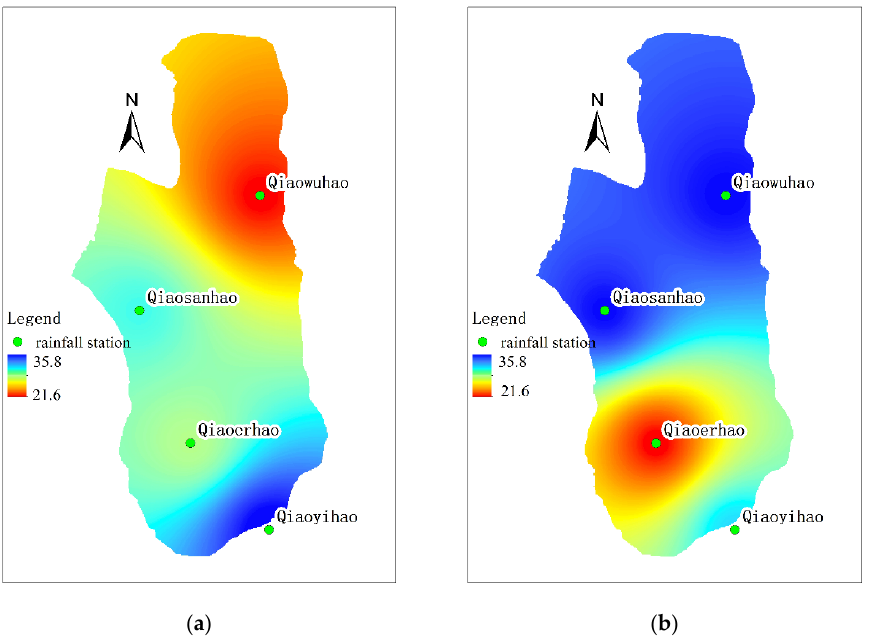
Figure 5. Rainfall spatial distribution on 18 September 2008 and 19 July 2009 in the Qiaogou water- shed: ( a ) 18 September 2008; ( b ) 19 July 2009 .